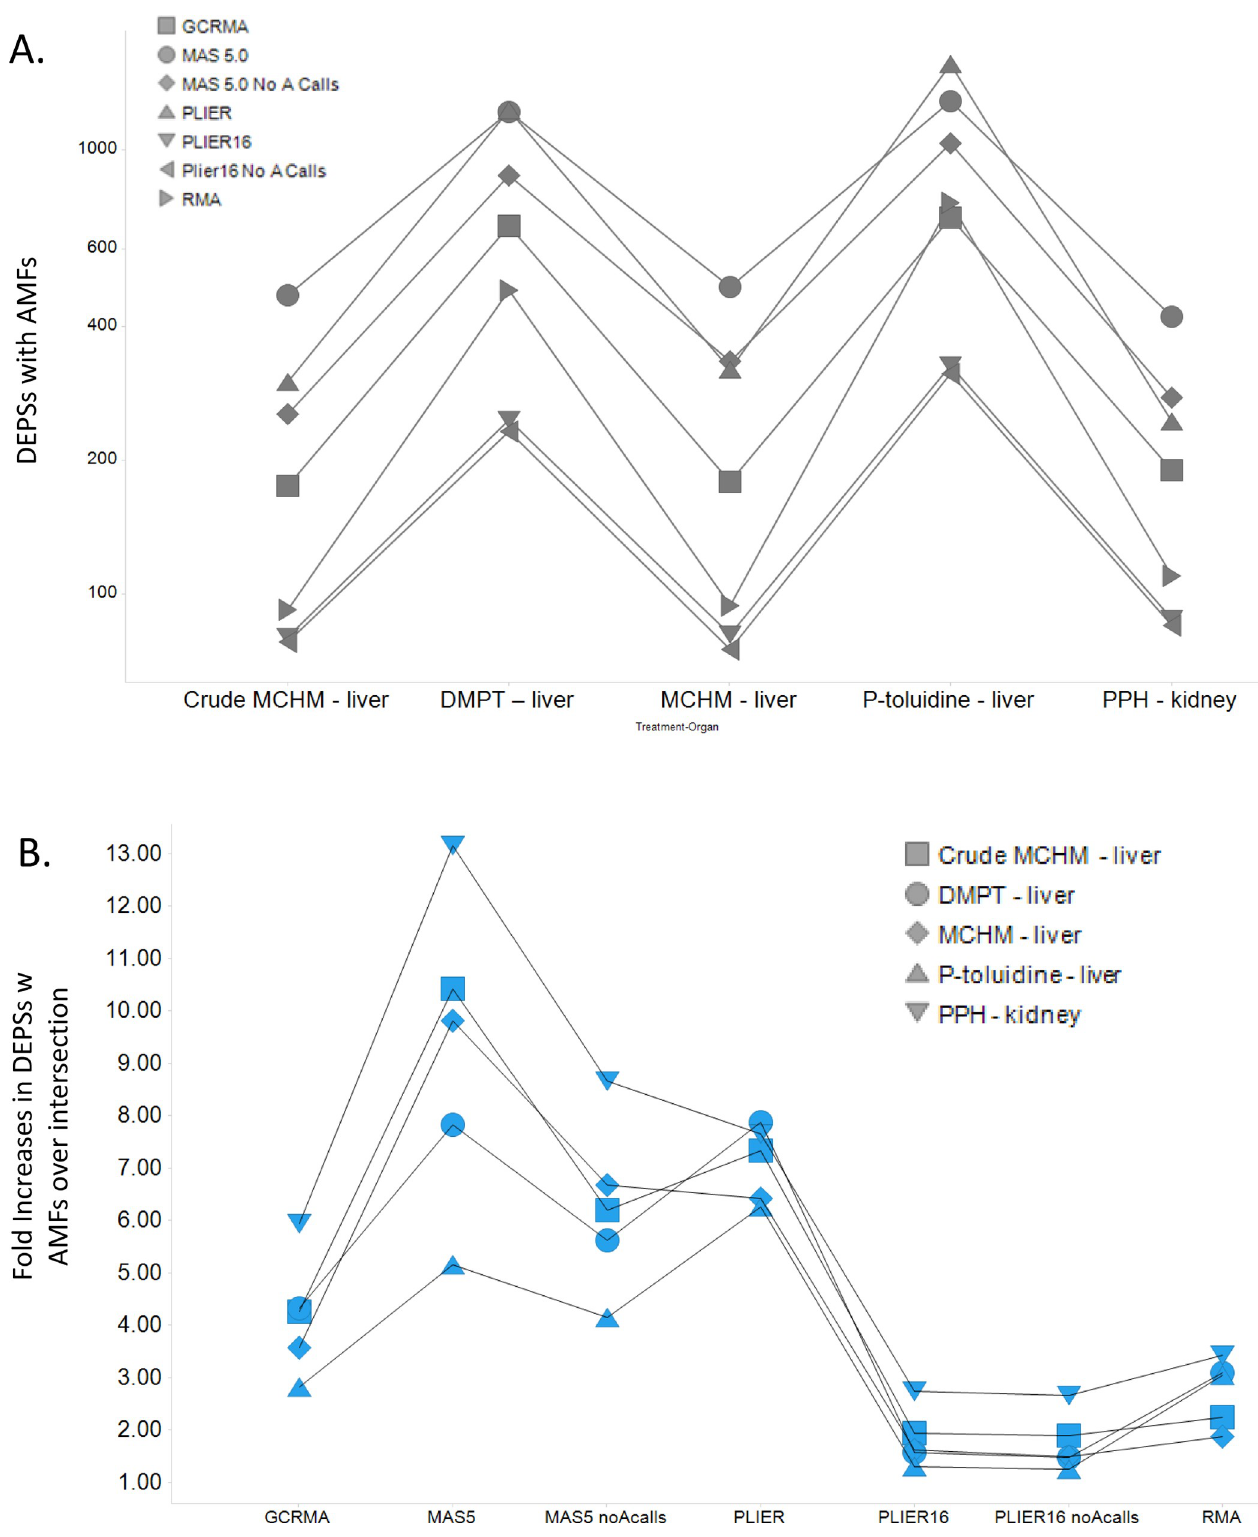
Fig 2. (A) Effect of different normalizations on the number of differentially expressed probe sets (DEPSs) with acceptable model fits (AMFs). (B) Fold increases in DEPSs over an intersection of all normalizations for any individual chemical-treatment pairs.